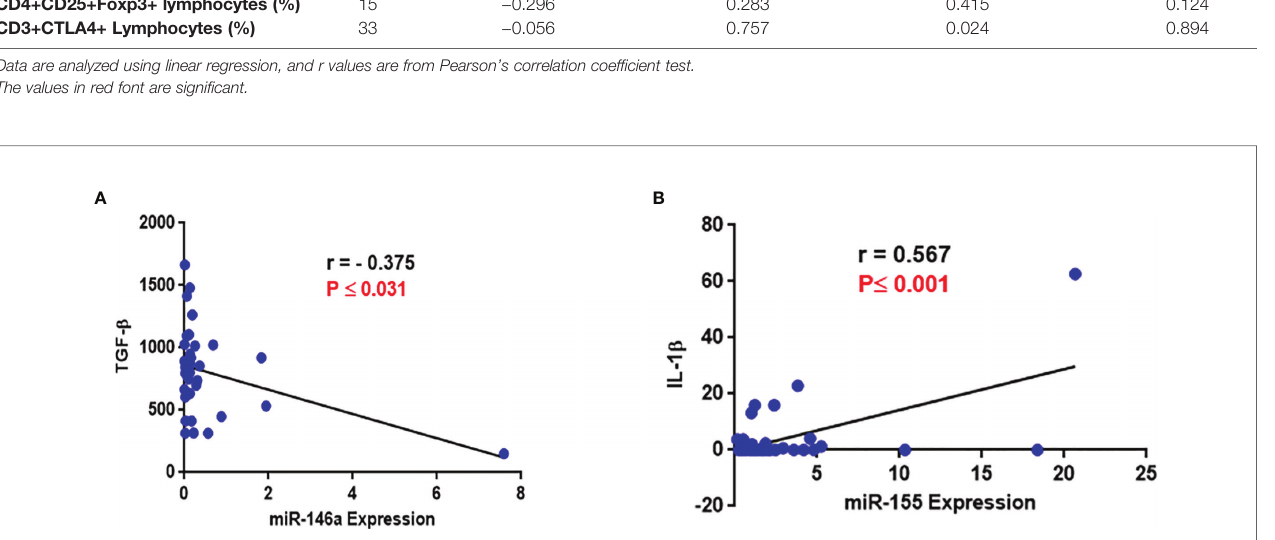
FIGURE 4 | Evaluation of correlation of miR-146a and miR-155 with cytokines (A) Correlation between miR-146a and TGF- b level; a negative correlation between miR-146a and TGF- b level was observed. (B) Correlation between miR-155 and IL-1 b level; a positive correlation between miR-155 and IL-1 b level was